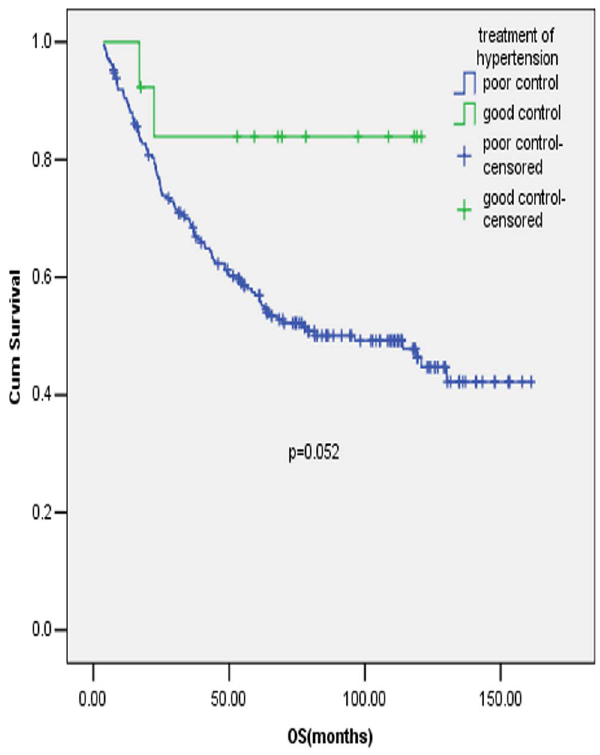
Figure 4. Prognostic value of antihypertension in early stage gastric cancer patients. Full legend: Survival curves of early stage GC patients who had the history of hypertension with blood pressure in good and poor